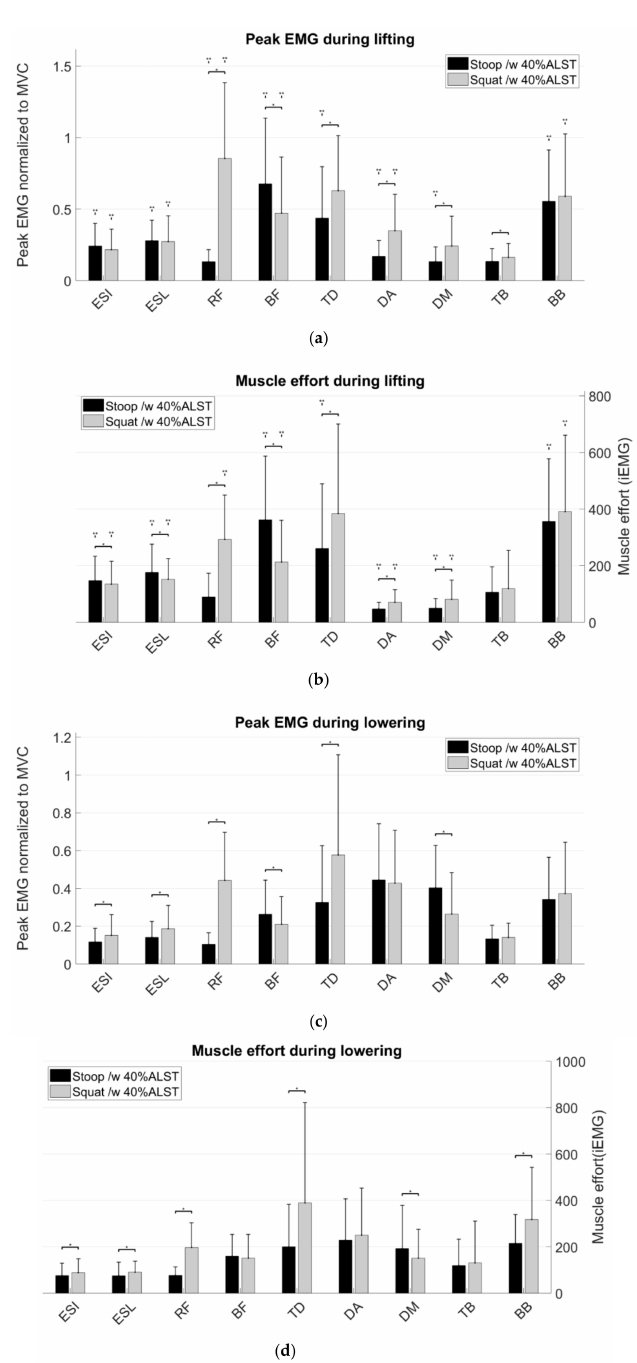
Figure 7. Peak electromyography (EMG) normalized to maximal voluntary contractions (MVC) during the two di ff erent lifting techniques (stoop and squat) for a load equal to 40% of the arm lifting strength test. Statistical significant di ff erences ( α < 0.05) between the handling phases are indicated with three dots, and statistical meaningful di ff erences between technique and loads are indicated with one dot. Error bars indicate standard deviations. ( a ) Peak measured EMG during the lifting phase in the nine muscles (erector spinae illiocostalis (ESI), erector spinae longissimus (ESL), rectus femoris (RF), biceps femoris (BF), trapezius descendens (TD), deltoideus anterior (DA), deltoideus medius (DM), triceps brachii (TB), and biceps brachii (BB)); ( b ) muscle e ff ort during lifting for the same nine muscles.; ( c ) peak EMG during the lowering phase for the nine muscles; ( d ) muscle e ff ort during the lowering phase for the same nine